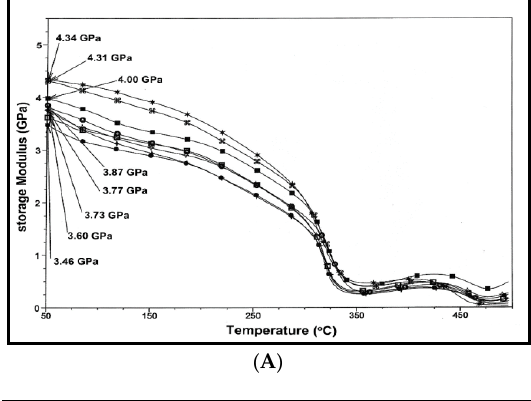
) and Ar-CNT-C ( ) (cid:35)